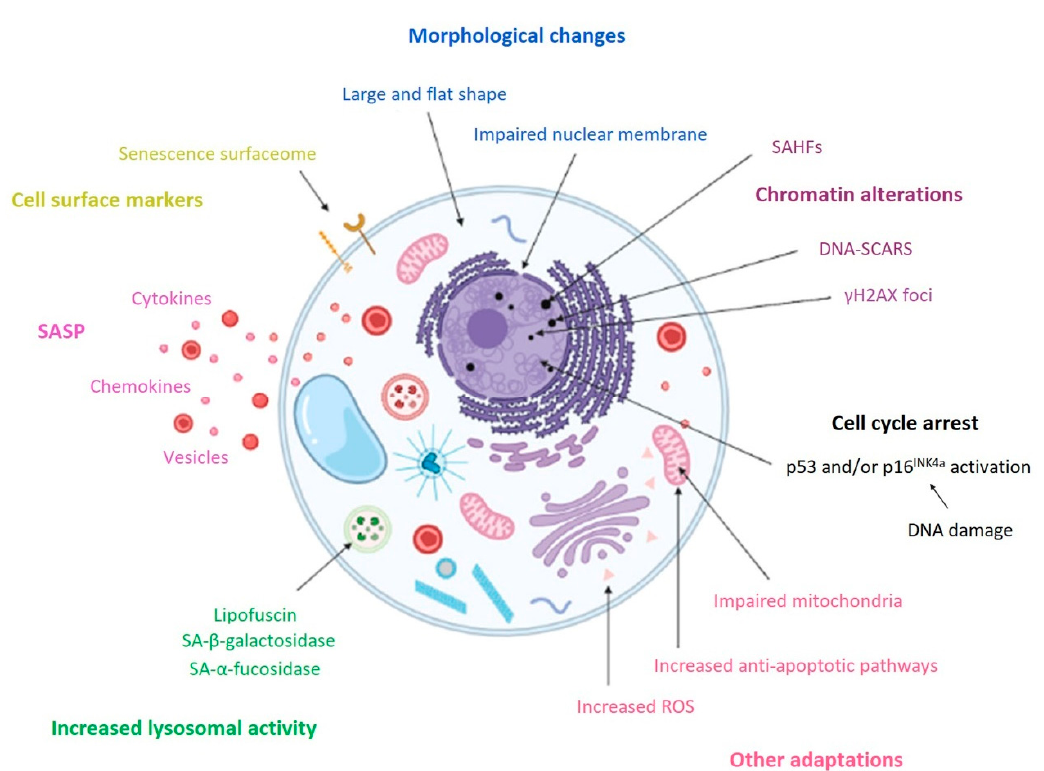
Figure 2. General hallmarks of cellular senescence. Markers strongly associated with senescence and seen in the majority of senescent cells include an enlarged size and flattened shape. The other features shown in this figure are not exclusive to senescence but are collectively considered hallmarks of the phenomenon. Senescent cells commonly exhibit the activation of the p53 and/or p16 pathways leading to irreversible cell cycle arrest, chromatin changes, and nuclear envelope disturbance. An increased lysosomal mass leading to enhanced SA- β -galactosidase activity is also often seen and, thus, SA- β -galactosidase activity is probably the most frequently used marker of senescence. Senescent cells may also exhibit strong paracrine secretion (SASP), severe mitochondrial disturbance associated with the activation of anti-apoptotic pathways, and other various characteristics.